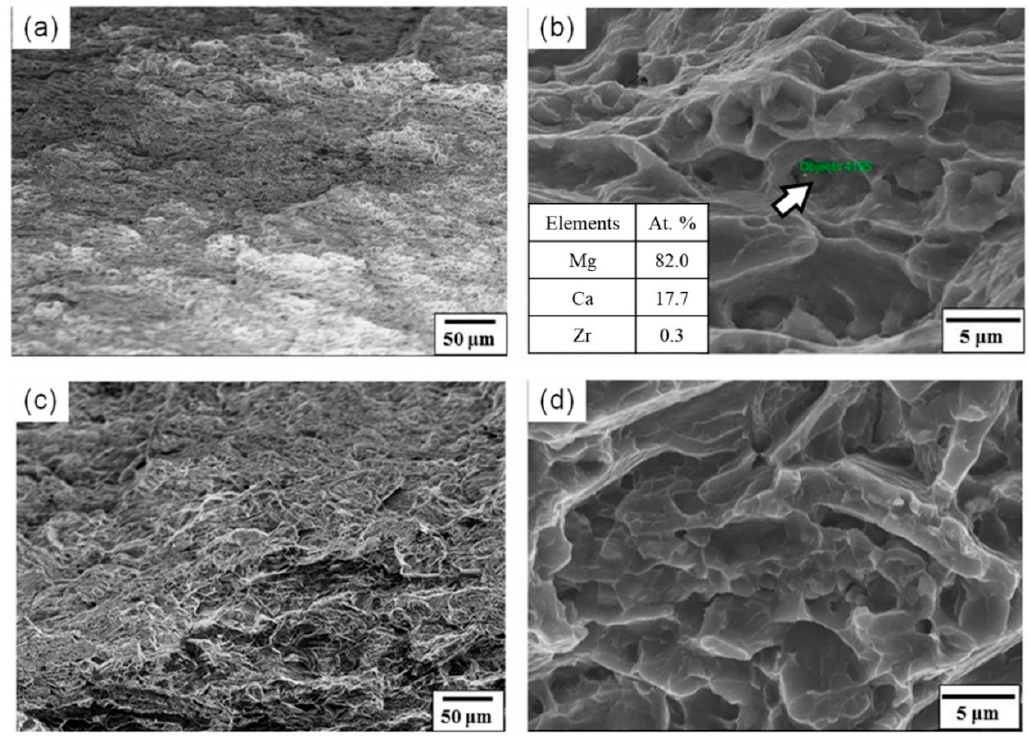
Figure 8. Tensile fracture morphology of XK105-H observed by SEM. Fracture surface on ( a , b ) ED plane and ( c , d ) TD plane.